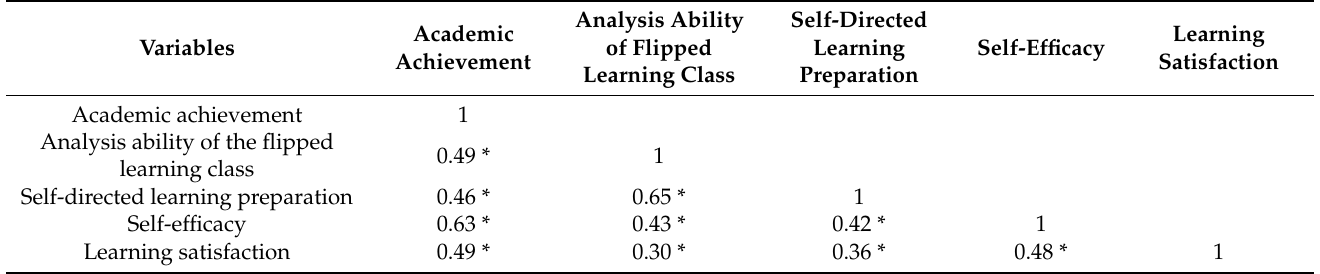
Table 4. Correlations in academic achievement, analysis ability of the flipped learning class, self-directed learning prepara- tion, self-efficacy, and learning